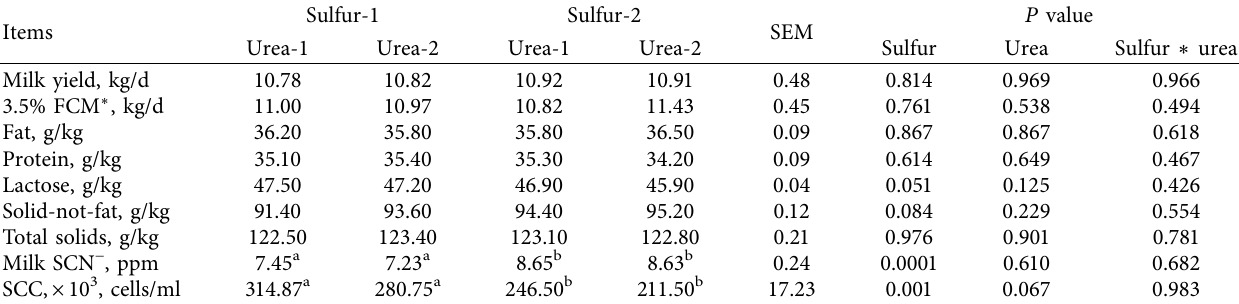
Table 6: Effect of sulfur and urea levels on milk yield and composition in dairy cows.